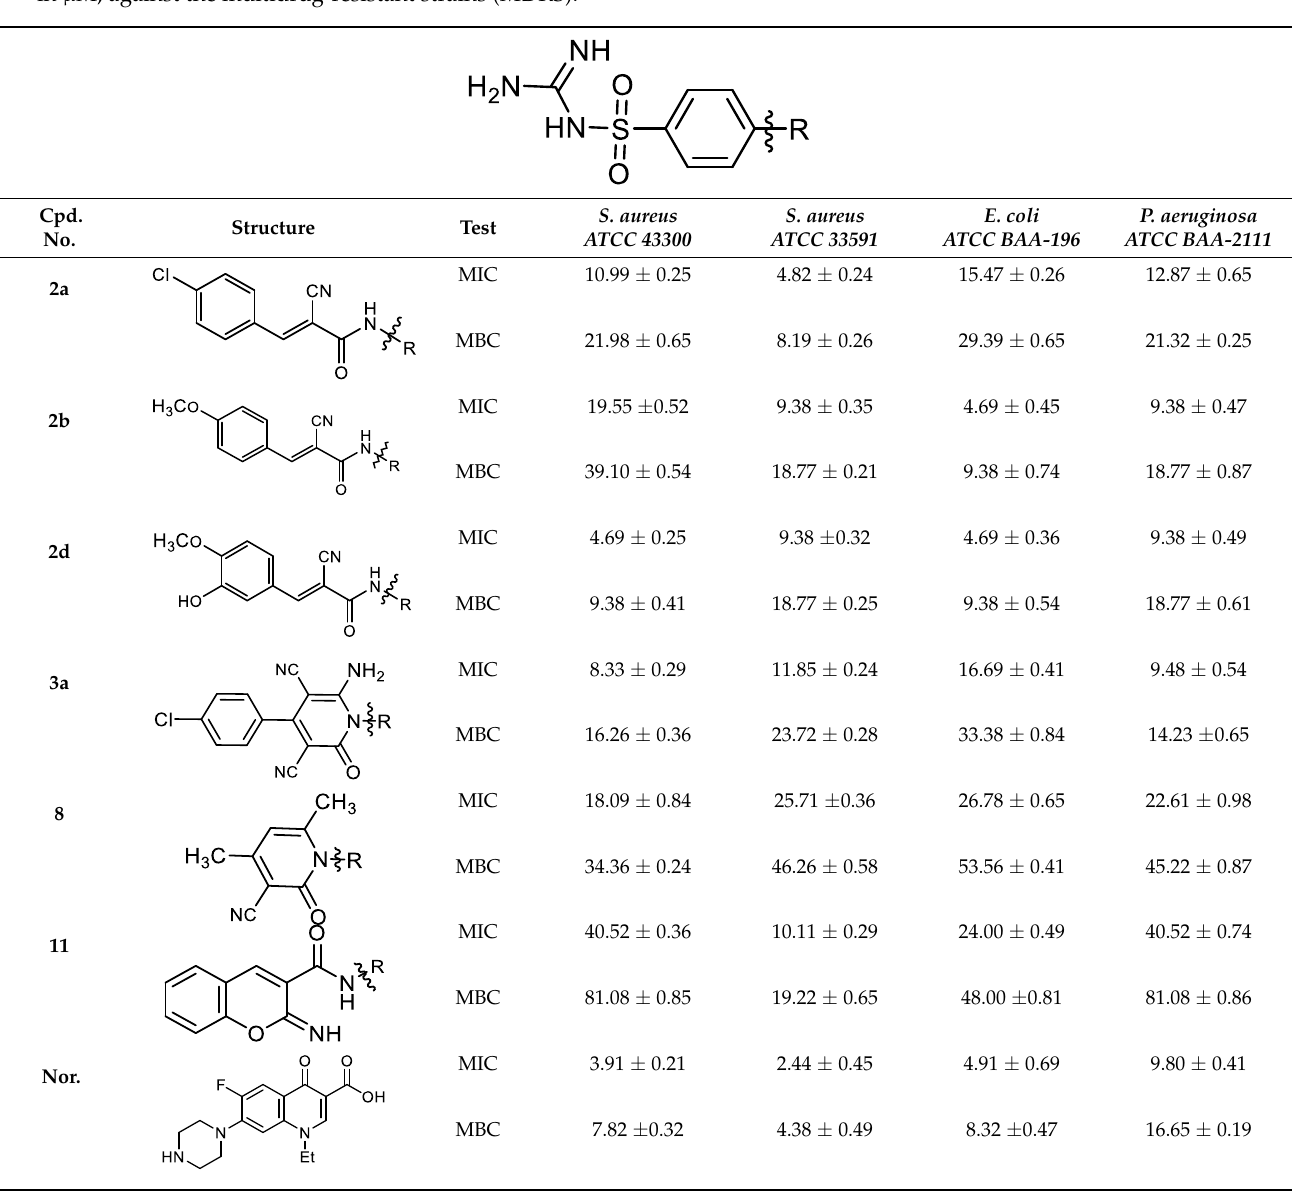
Table 4. In vitro antibacterial activity by inhibition zone (IZ) of the most potent compounds against multidrug-resistant bacteria (MDRB). Cpd. No.